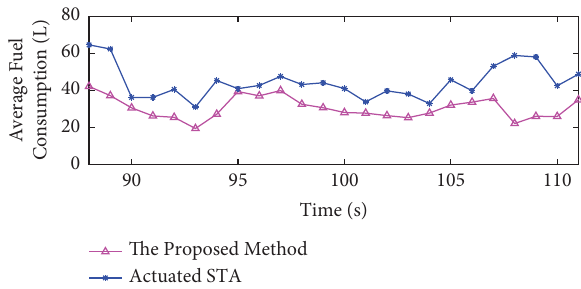
Figure 8: Test results of fuel consumption with two